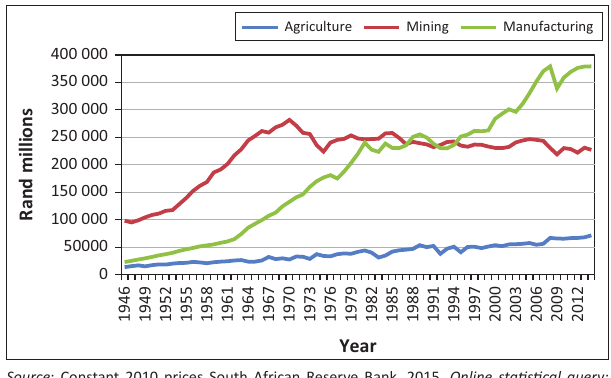
FIGURE 9: South African growth in heavy vehicle population (eNatis 2015) compared with rail wagons (Transnet Freight Rail 2015).